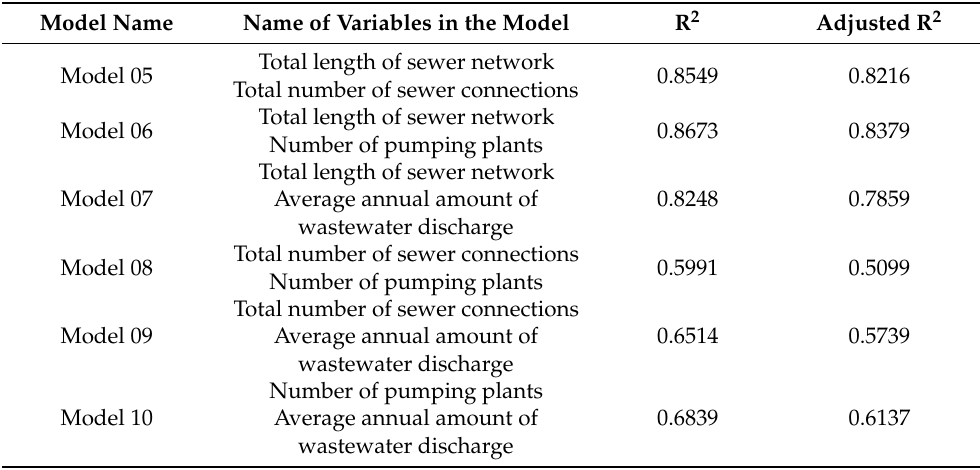
Table 8. Proposal for variables of the maintenance cost estimation models with two variables.